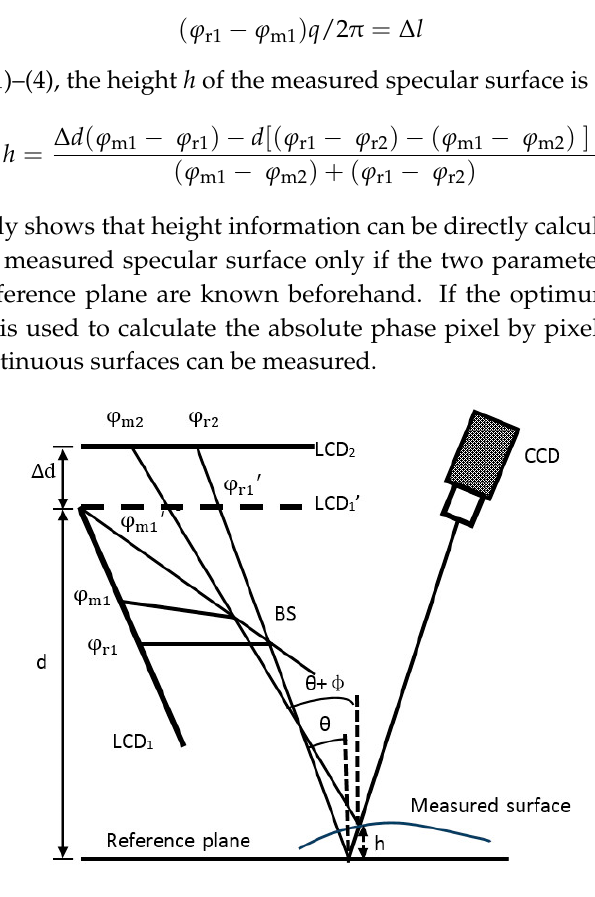
Figure 2. Schematic of the 3D measurement system based on DPMD.